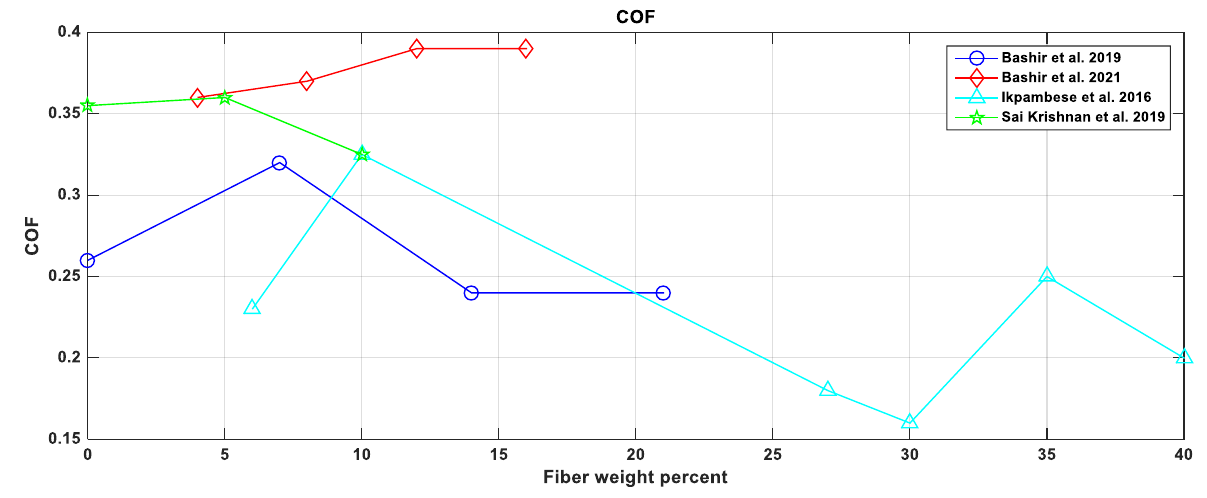
Figure 5. ( a ) The variation of hardness using the Brinell tester for banana fiber with variation in the fiber weight percentage [43], ( b ) illustrates variation of hardness using inertia dynamotor palm ker- nel fiber with variation in the fiber weight percentage [56], and ( c ) variation of hardness using Rock-